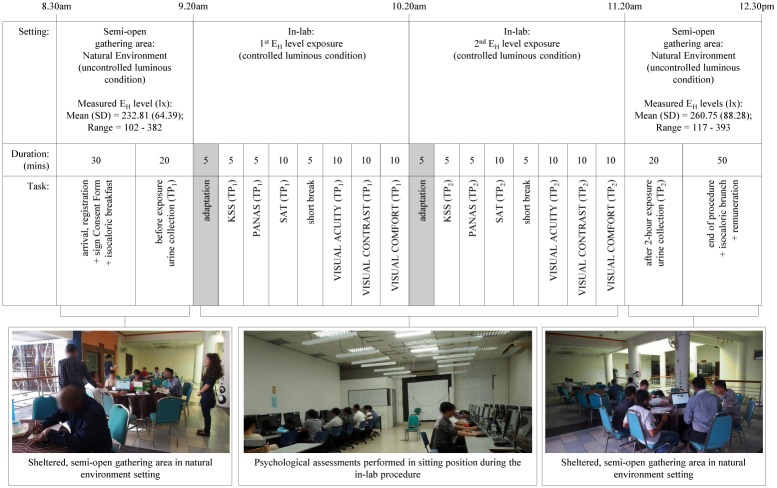
Details of the experimental procedure for each session.